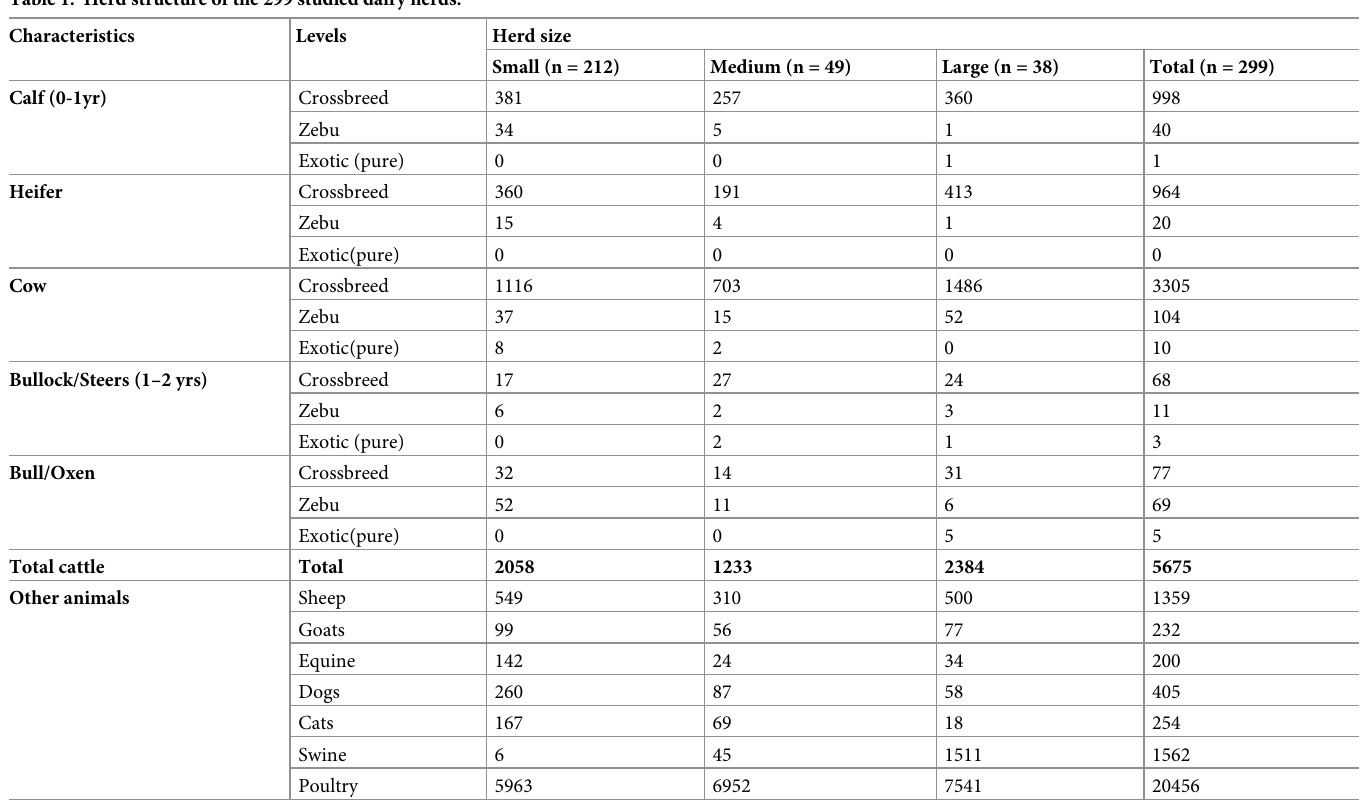
Table 1. Herd structure of the 299 studied dairy herds.